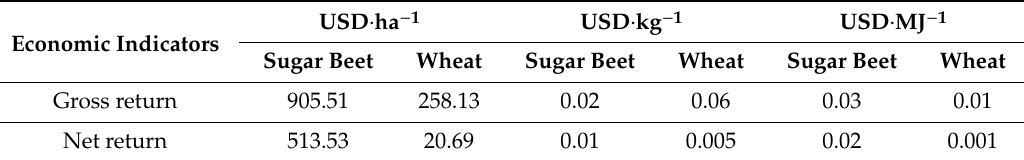
Table 3. Economic analysis of the sugar beet and wheat production